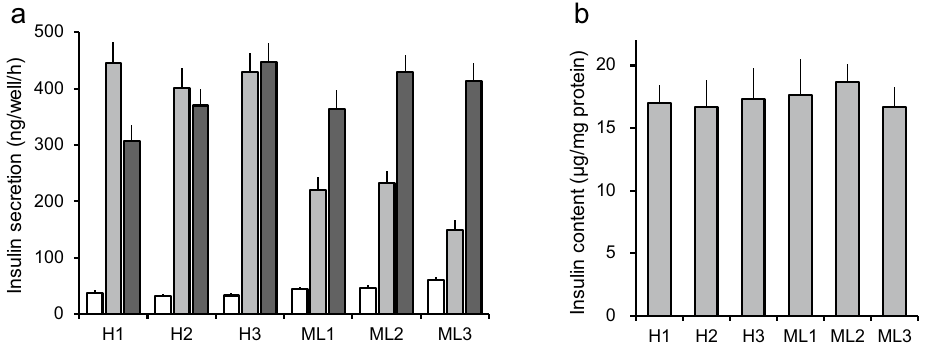
Figure 1. MIN6cl4 sublines with high and mildly low glucose-responsiveness. ( a ) Insulin secretion evoked by glucose (5 mM, white bars; 20 mM grey bars) or 30 mM KCl (black bars) from sublines with high glucose- responsiveness (H1, H2, H3) and from sublines with mildly low glucose-responsiveness (ML1, ML2, ML3). Data are presented as means ± SE, n = 3 wells. The results shown are representative of two independent experiments with similar results. ( b ) Insulin contents in MIN6cl4 sublines. Data are presented as means ± SE, n = 3 wells. The results shown are representative of two independent experiments with similar